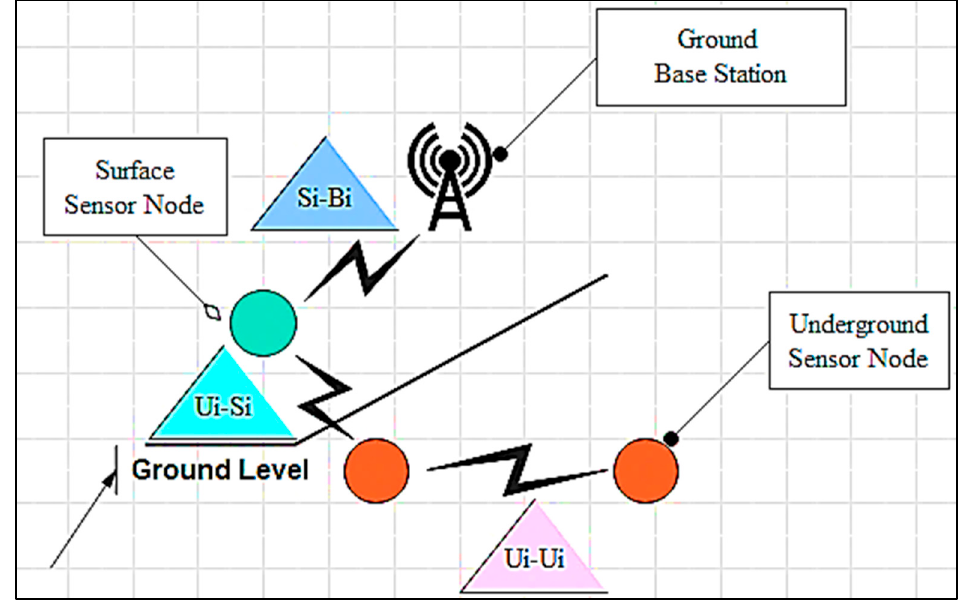
Figure 1. Links and nodes .